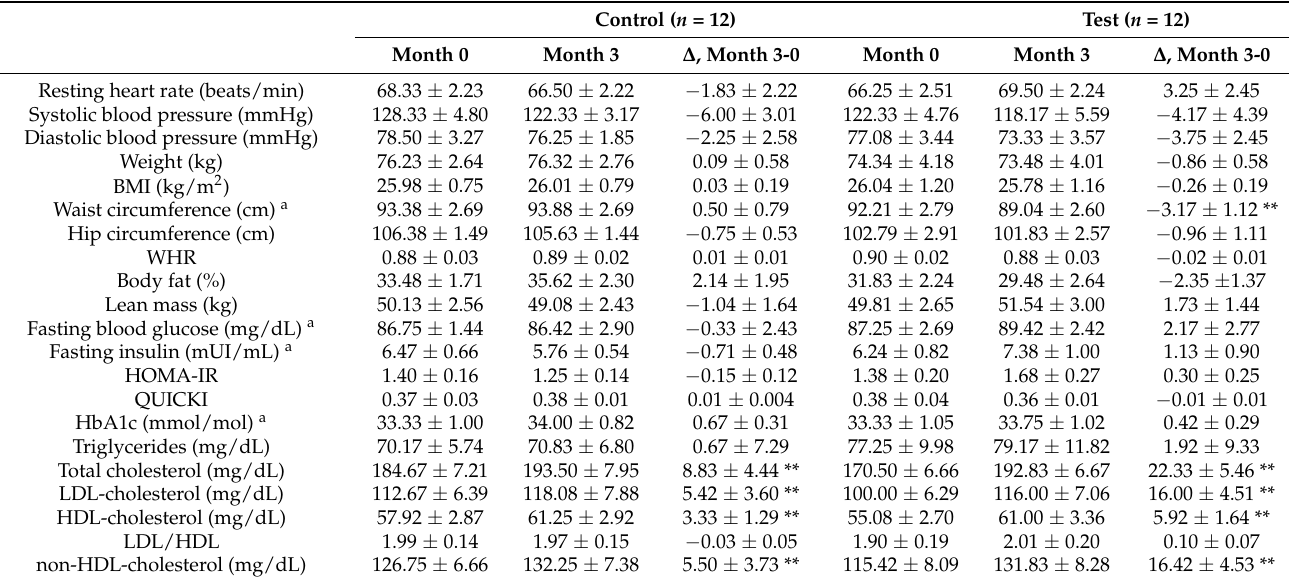
Table 4. Changes in blood pressure, anthropometric measurements, glycaemic parameters and serum lipids between start and end of